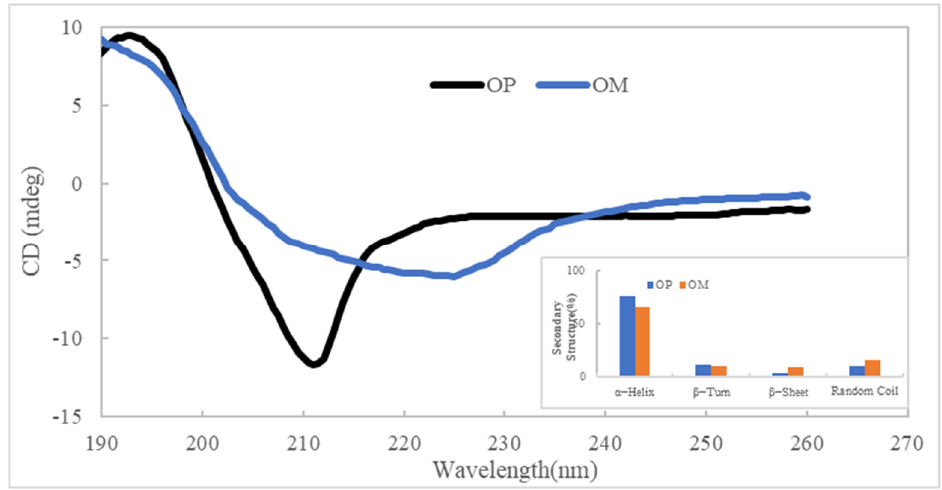
Figure 3. Circular dichroism of OM and OP .